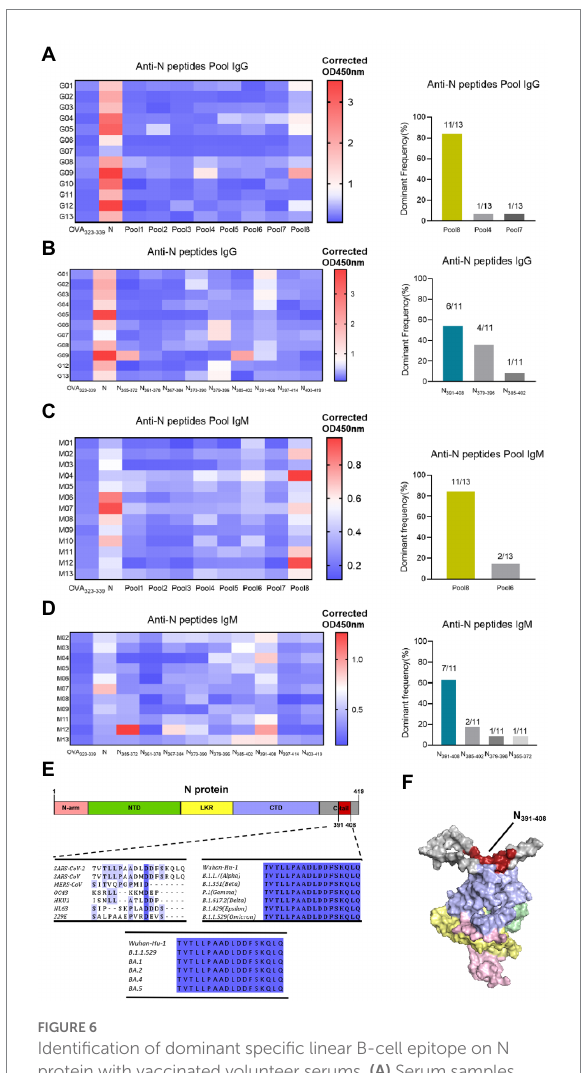
FIGURE 6 Identification of dominant specific linear B-cell epitope on N protein with vaccinated volunteer serums. (A) Serum samples (1:25 dilution) were tested in a peptide-based ELISA of peptide pools covering SARS-CoV-2 N protein for IgG. Each pool consists of 8–9 18-mer overlapping peptides. Antibody response levels were detected by indirect ELISA assay with OVA 232-339 , N protein as the negative and positive control, respectively. OD450nm values are presented in a heatmap, with blue and red colors denoting low and high OD450nm values, respectively. The dominant frequency of different pools also had been counted in the histogram. Thirteen individuals with the highest N-specific IgG response levels were selected. Dominant Frequency (%) was calculated as dominant peptide (pool) frequency divided by total frequency. (B) Individual peptide of the dominant peptide pools in (A) were tested to determine the IgG dominant peptide. Serums were from pool8-dominant volunteers ( n = 11). The dominant frequency of different peptides also had been counted in the histogram. (C) IgM responses to N protein peptide pools. Serums were from 13 high protein-ELISA OD value vaccinated volunteers. (D) IgM responses to the individual peptide of pool8. Serum were from pool8-dominant volunteers ( n = 11). (E) Dominant epitope sequence alignment among 7 human- infected coronaviruses and SARS-CoV-2 variant strains. The depth of amino acid blue background indicates the degree of homology. (F) Localization of N 391-408 on the 3-D structure of N protein. Red represents the dominant epitope N 391-408 . N-arm, NTD, LKR, CTD, and C-tail are shown as pink, green, yellow, purple, and gray,